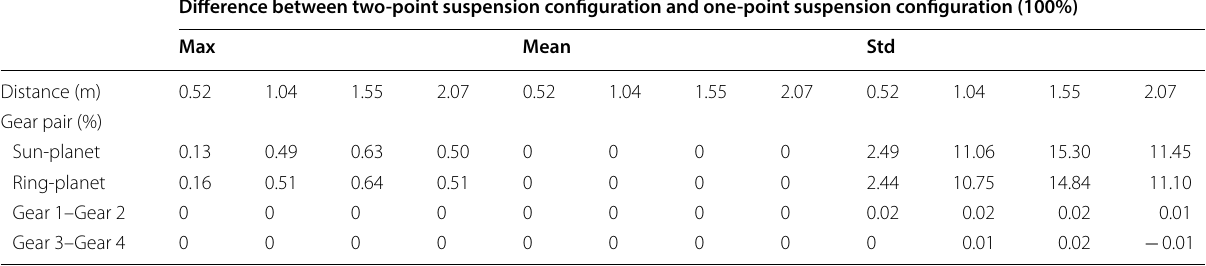
Table 2 Comparisons of dynamic mesh forces under the rated operating